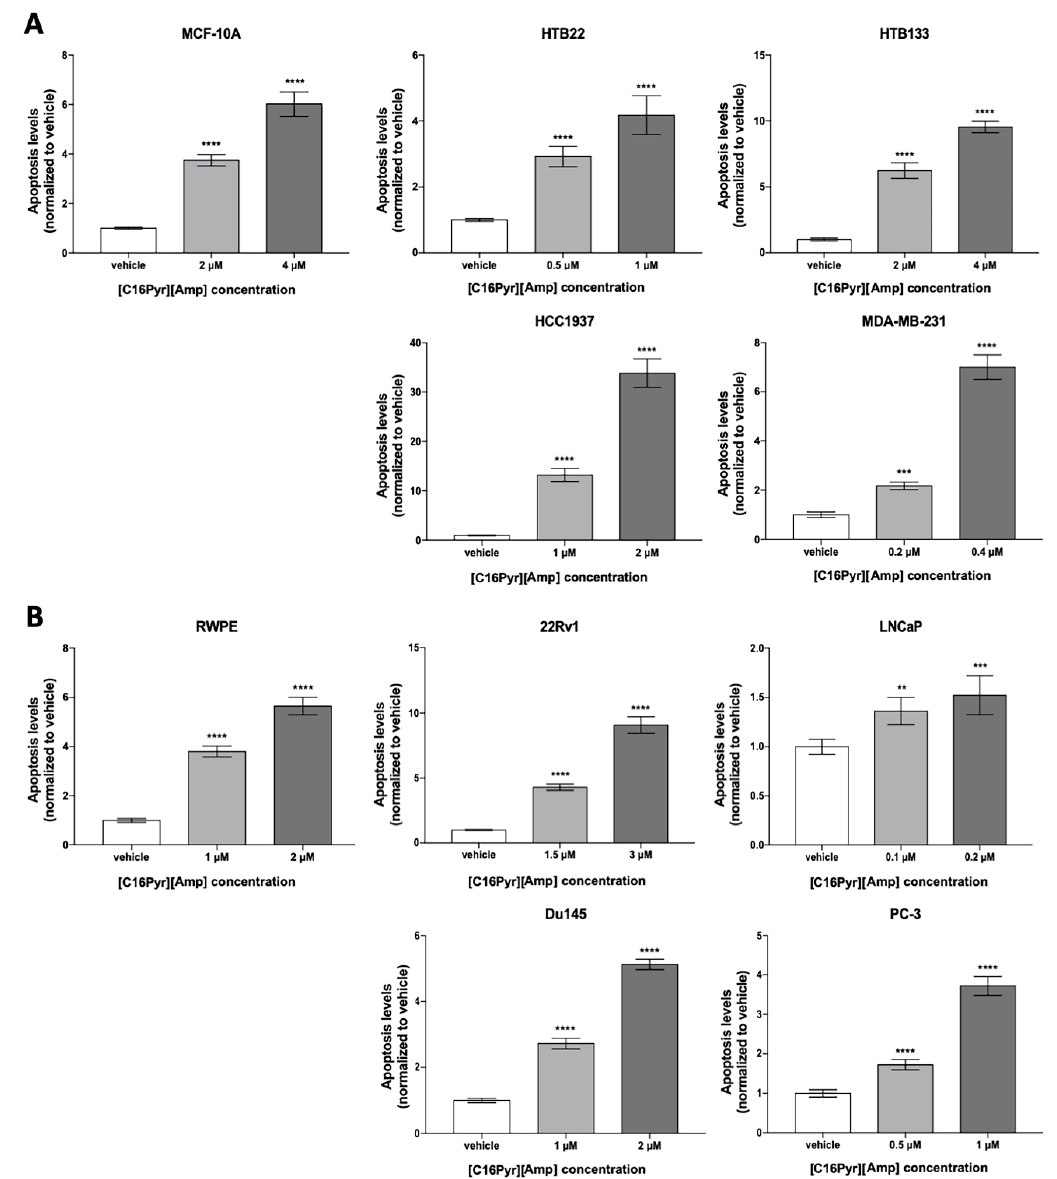
Figure 2. The impact of [C16Pyr][Amp] on apoptosis levels on day 3 after treatment was measured and compared with the vehicle for the ( A ) BrCa and ( B ) PCa cell lines. All data are presented as mean of three independent experiments ± SD. ** p < 0.01; *** p < 0.001; **** p < 0.0001).